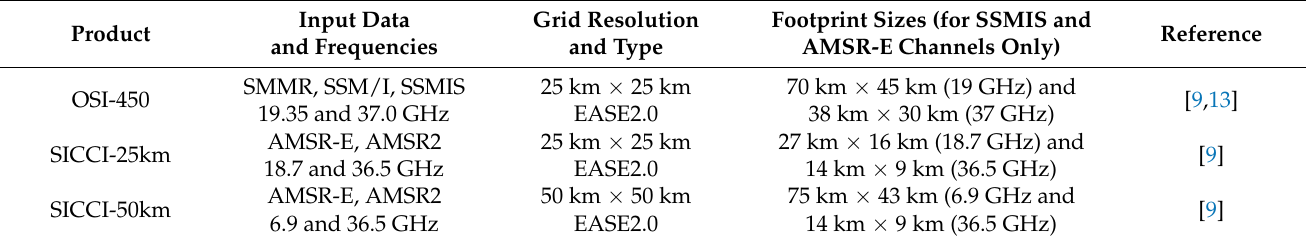
Table 1. Overview of the investigated sea-ice concentration